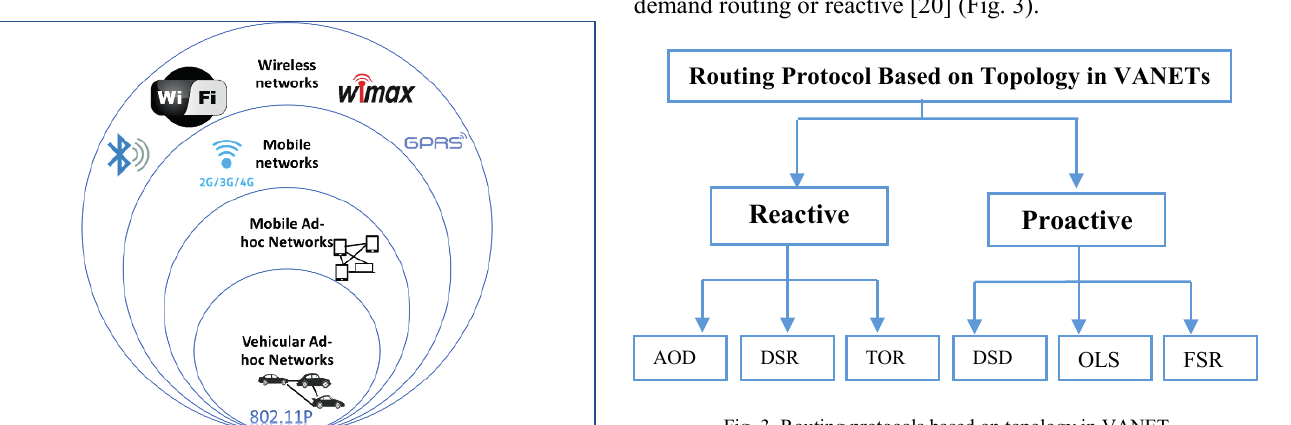
Fig. 3. Routing protocols based on topology in